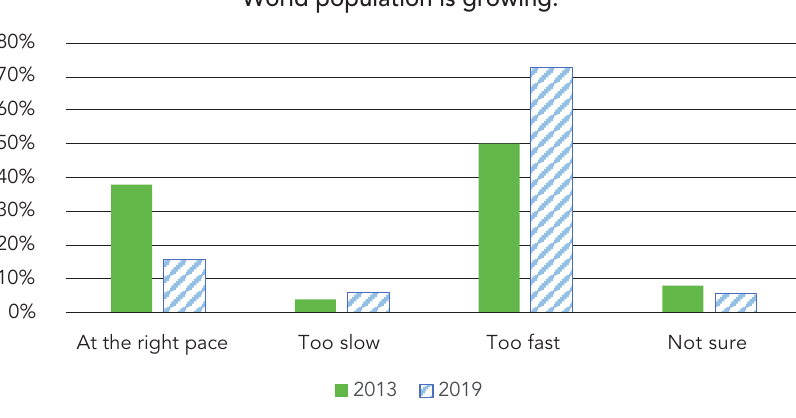
Chart 3: Attitudes: In 2018 the world population reached 7.6 billion. The world’s population is projected to reach 11 billion by the end of the century. Do you think the world’s population is growing World population is